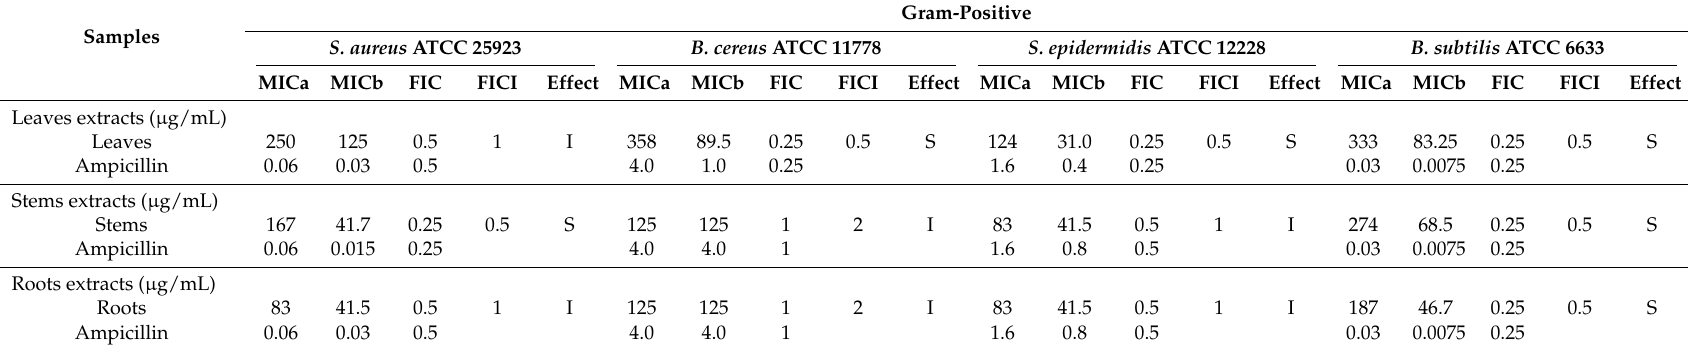
Table 3. Fractional inhibitory concentration index (FICI); combination of alkaloid extract of Berberis microphylla with ampicillin.